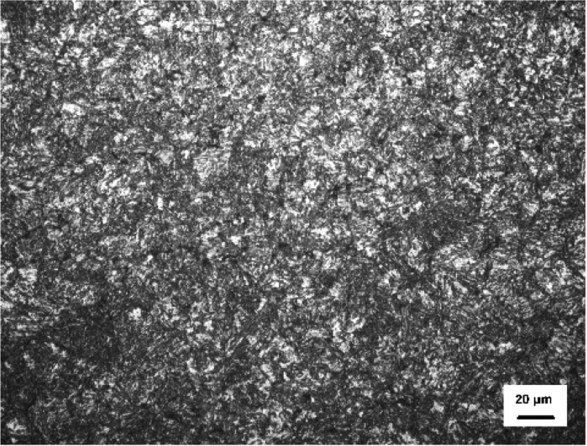
Figure 10: Microstructures of 49MnVS3 non-quenched and tempered steel at temperature of 850°C and strain rate of 50 s −